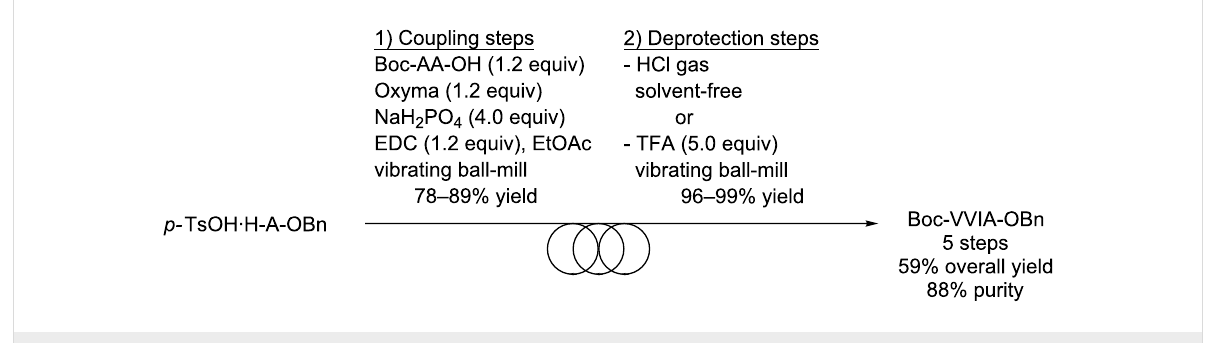
Scheme 1: Synthesis of Boc-VVIA-OBn by the ball-milling approach.